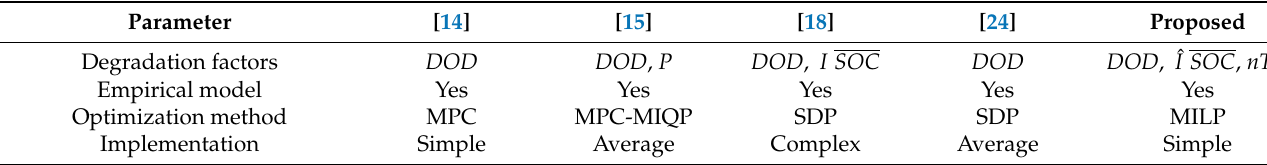
Table 4. Comparison with other state-of-the-art